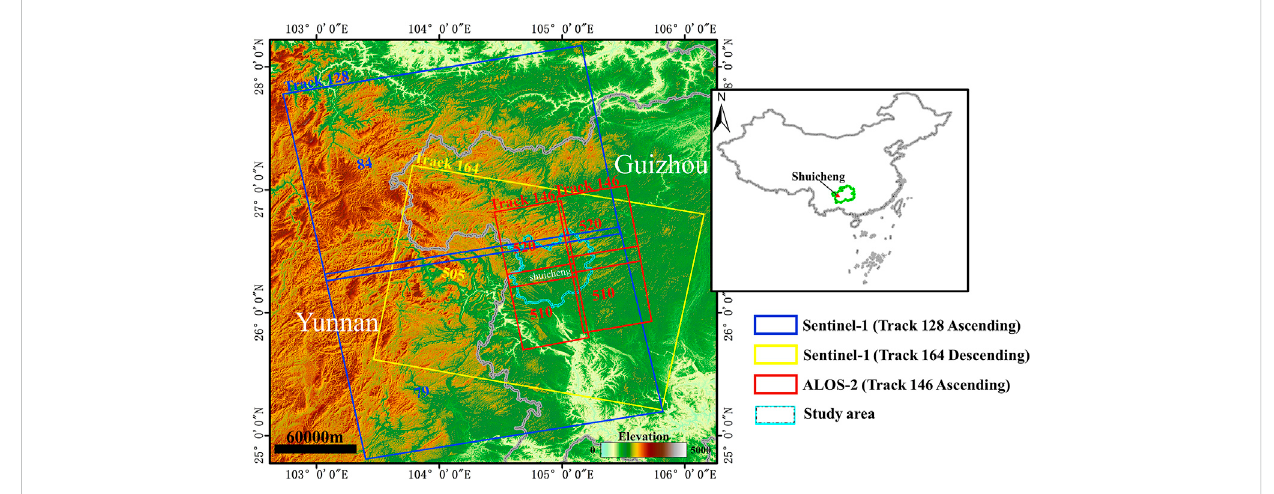
FIGURE 1 The geographic location ofthestudy areaand thecoverageofSentinel-1A andALOS/PALSAR-2 SARimages. The background istheshaded relief of